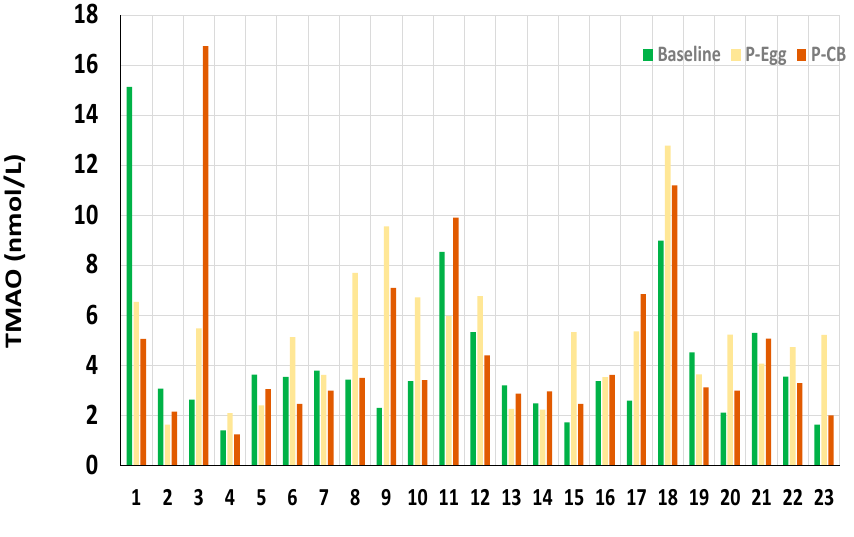
Figure 2. Plasma concentration of TMAO at baseline and post-consumption of 3 eggs/d (P-Egg) or CB supplementation (P-CB) for 4 weeks. Data is shown for the 23 subjects at each time point: baseline, after the egg intervention (P-Egg), and after the choline supplement (P-CB).